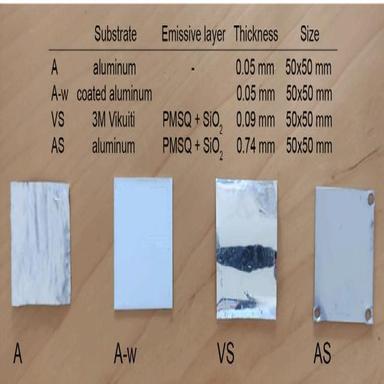
Main geometry features of the investigated reference samples (A and A-w) and radiative cooling samples (AS and VS).